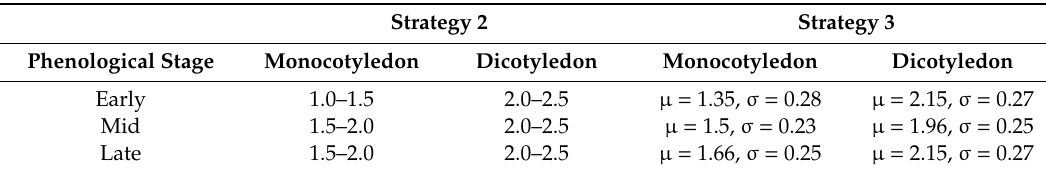
Table 6. Parameterization of the N s parameter in PRO4SAIL. Values in the strategy 2 column were used as the minimum and maximum range bounds for generating uniform N s values while the values in strategy 3 were used as the mean and standard deviation values for generating gaussian N s values. Values based on Table 2 results in Boren et al.